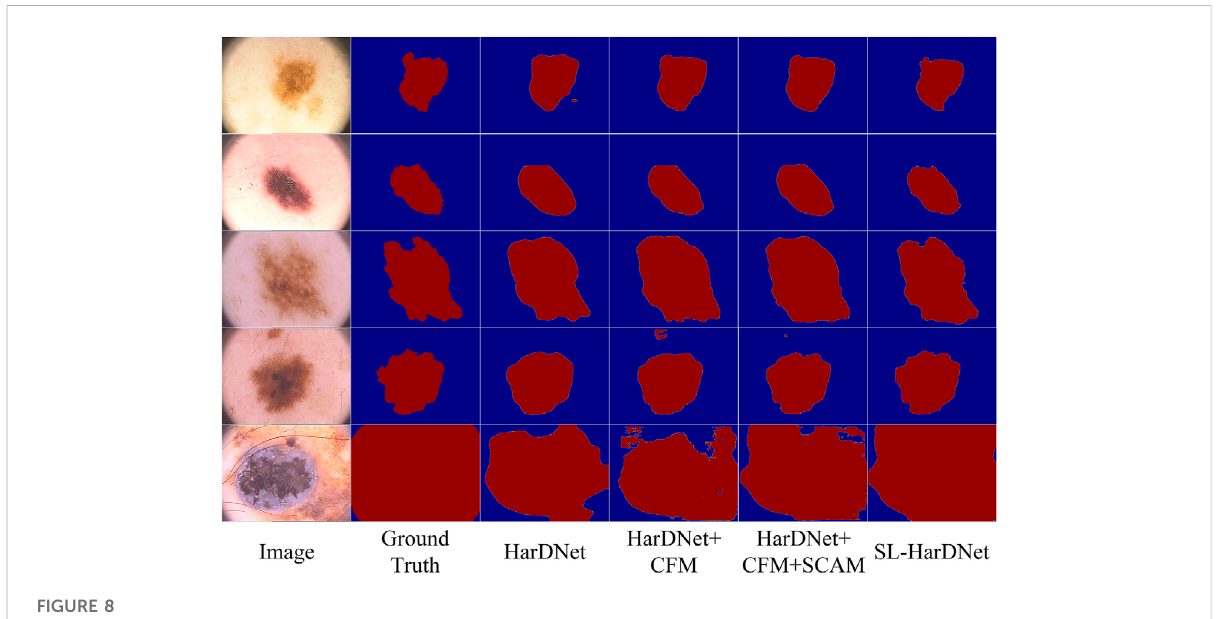
FIGURE 8 Visualization of the ablation study results.